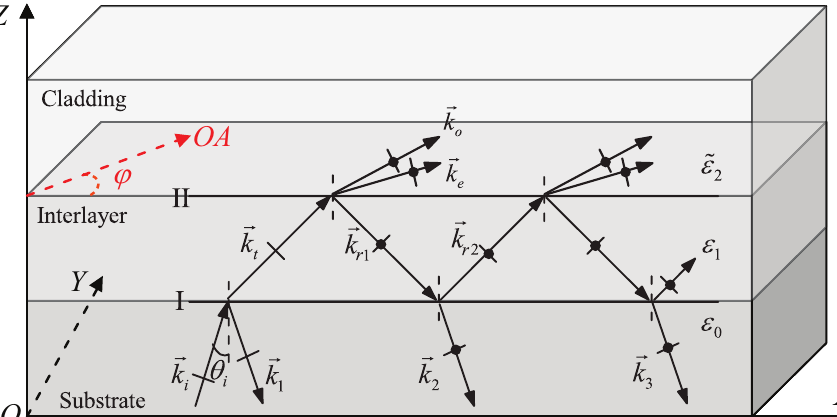
Figure 1. Reflection of a transverse magnetic (TM) plane wave in a three-layer dielectric system, where both the substrate and the interlayer are isotropic media, and the cladding is a uniaxial dielectric with optical axial (OA) parallel to the